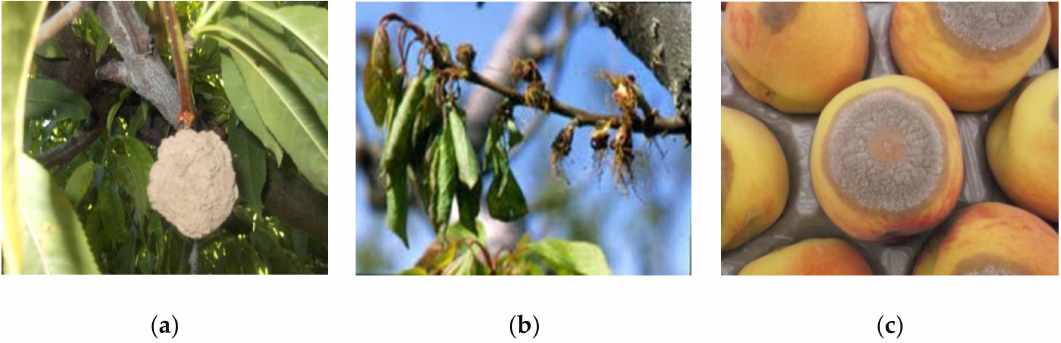
Figure 7. Infection chain of Monilinia laxa in host peach. ( a ) Mummified peach; ( b ) blighted blossoms; ( c ) infected peach